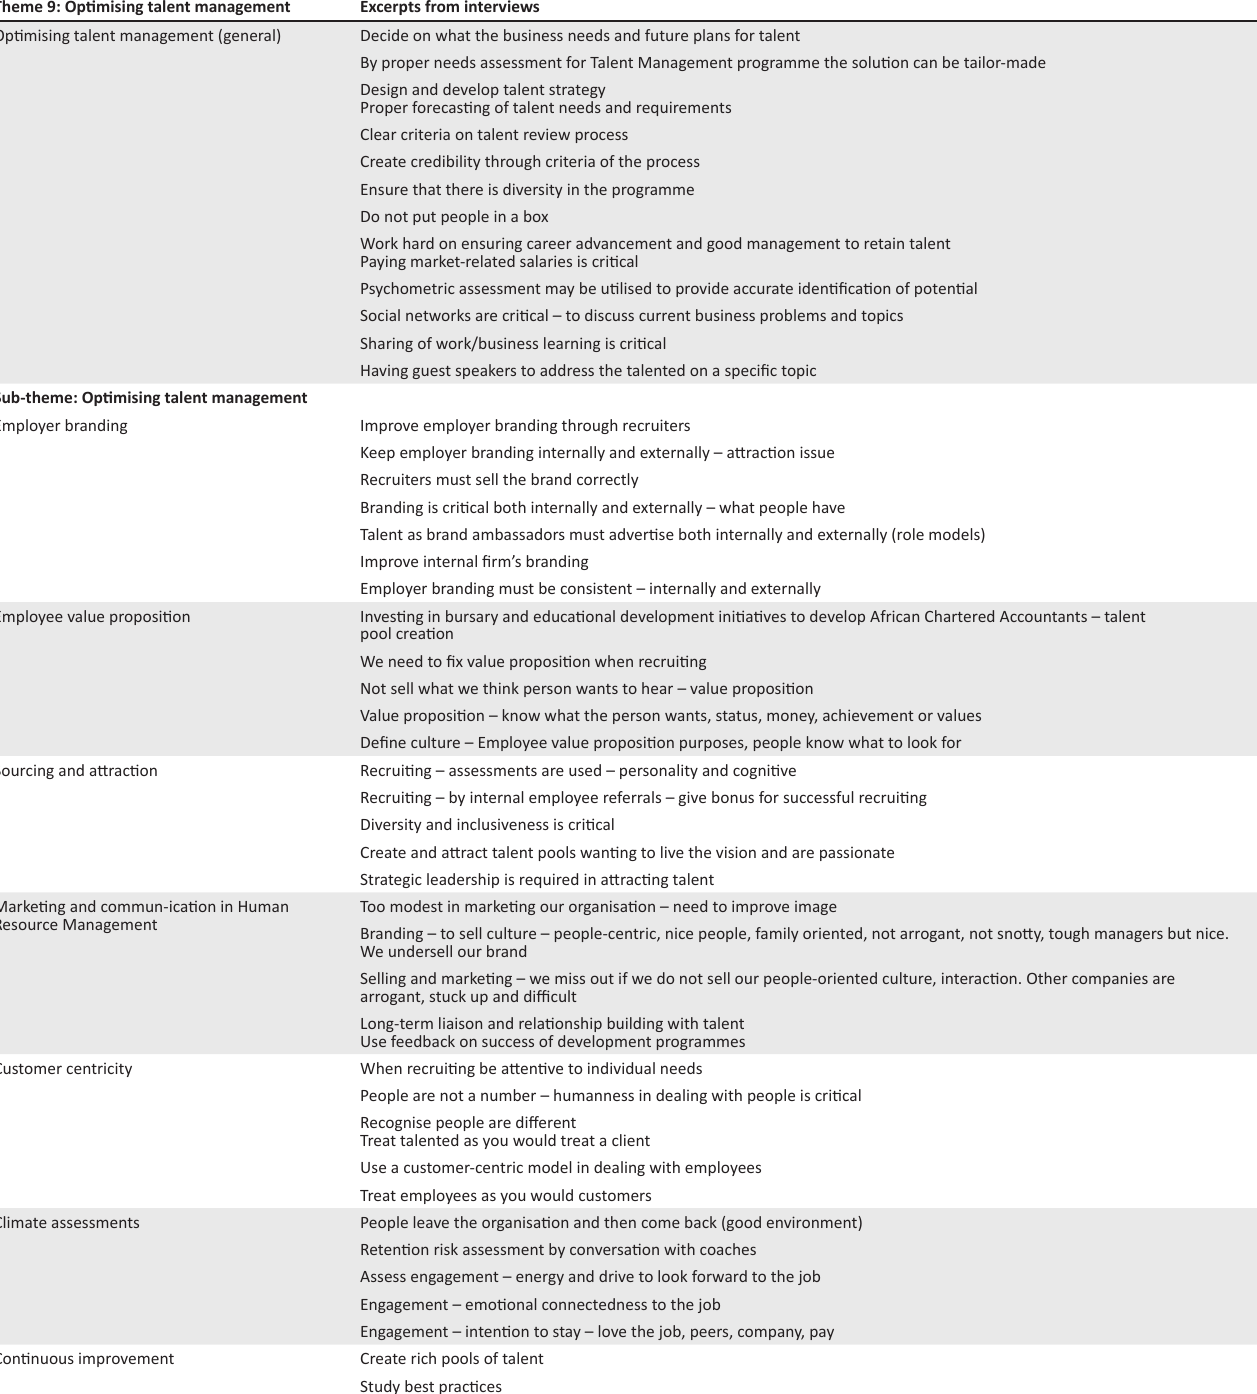
TABLE 9: Optimising talent management. Theme 9: Optimising talent